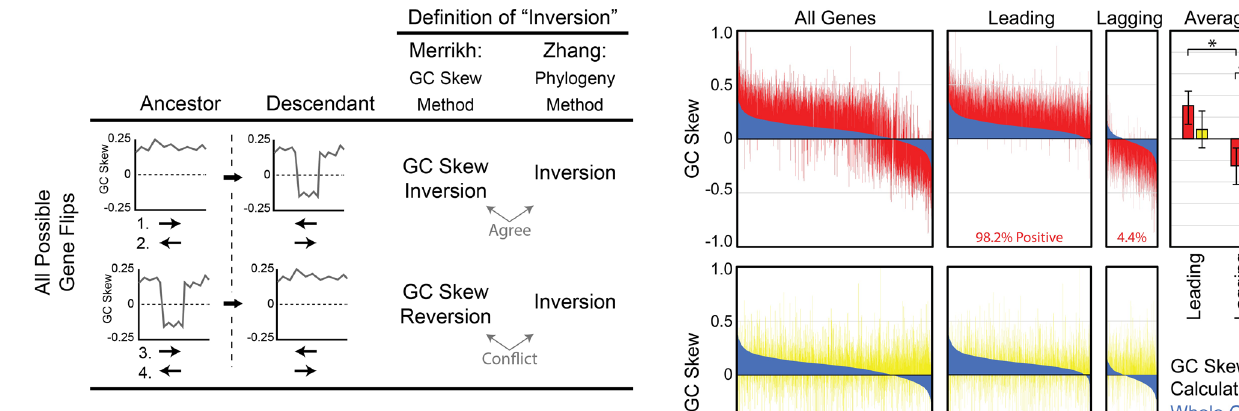
Fig. 1 Comparison of gene “ inversion ” de fi nitions and detection methods.